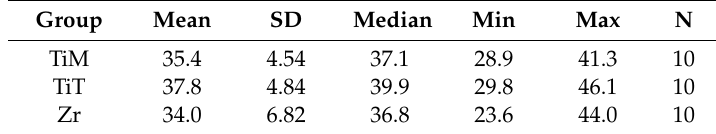
Table 3. Comparison of the bone-implant contact (%) between the groups. Group